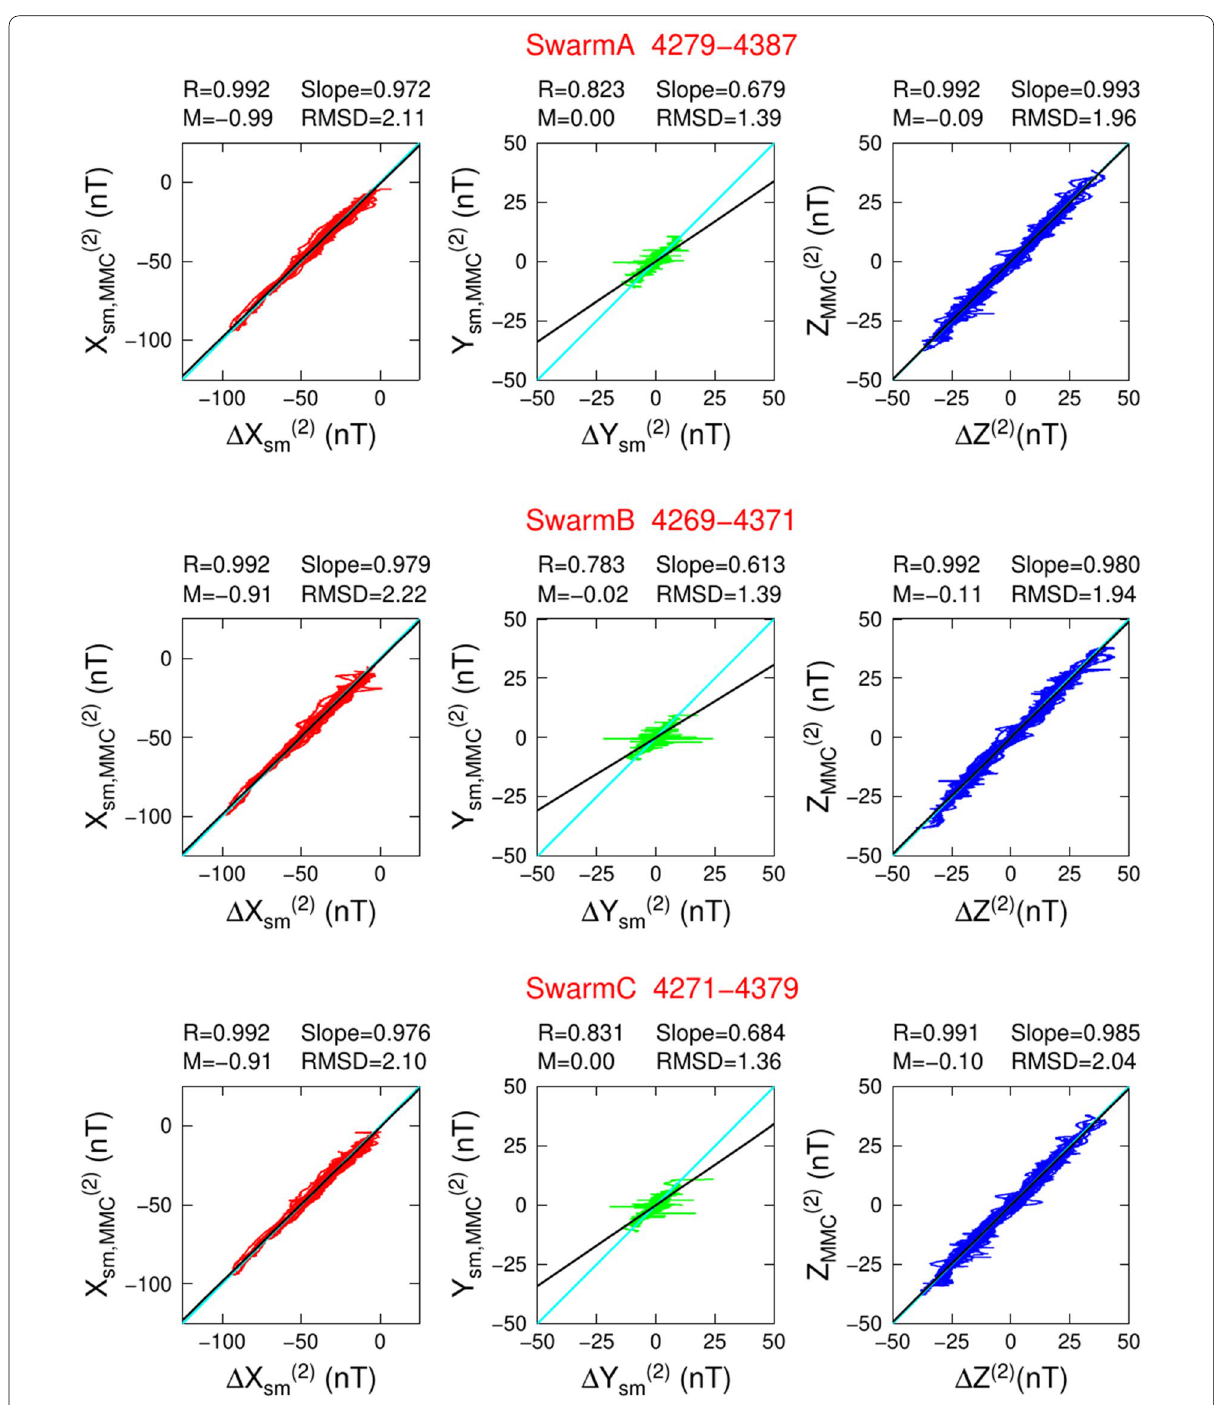
Fig. 15 The same as Fig. 5, but for the magnetic field components X ( 2 ) sm,MMC , Y ( 2 ) sm,MMC and Z ( 2 ) MMC due to the two-circular loop model of MRCs and MICs. The analysis of residuals is carried out in bins of 1-h